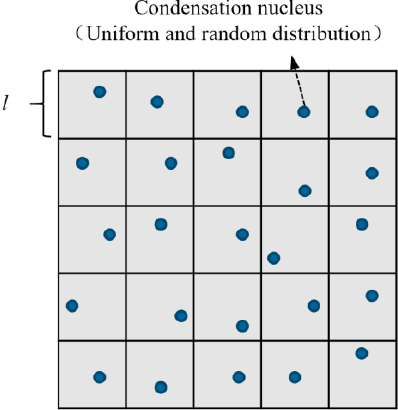
Figure 1. Distribution of condensation nuclei.